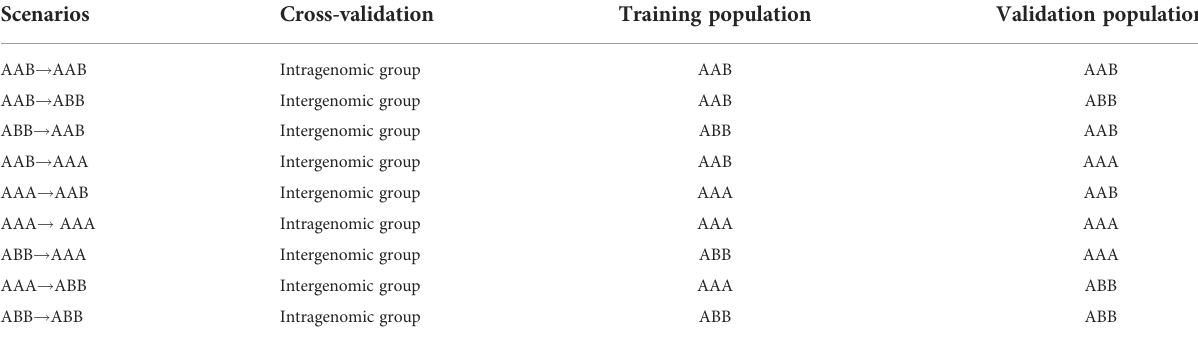
TABLE 2 Scenarios to study the effect of genomic group composition on GS accuracy of banana triploid cultivars phenotyped for drought- and BSD-related traits.